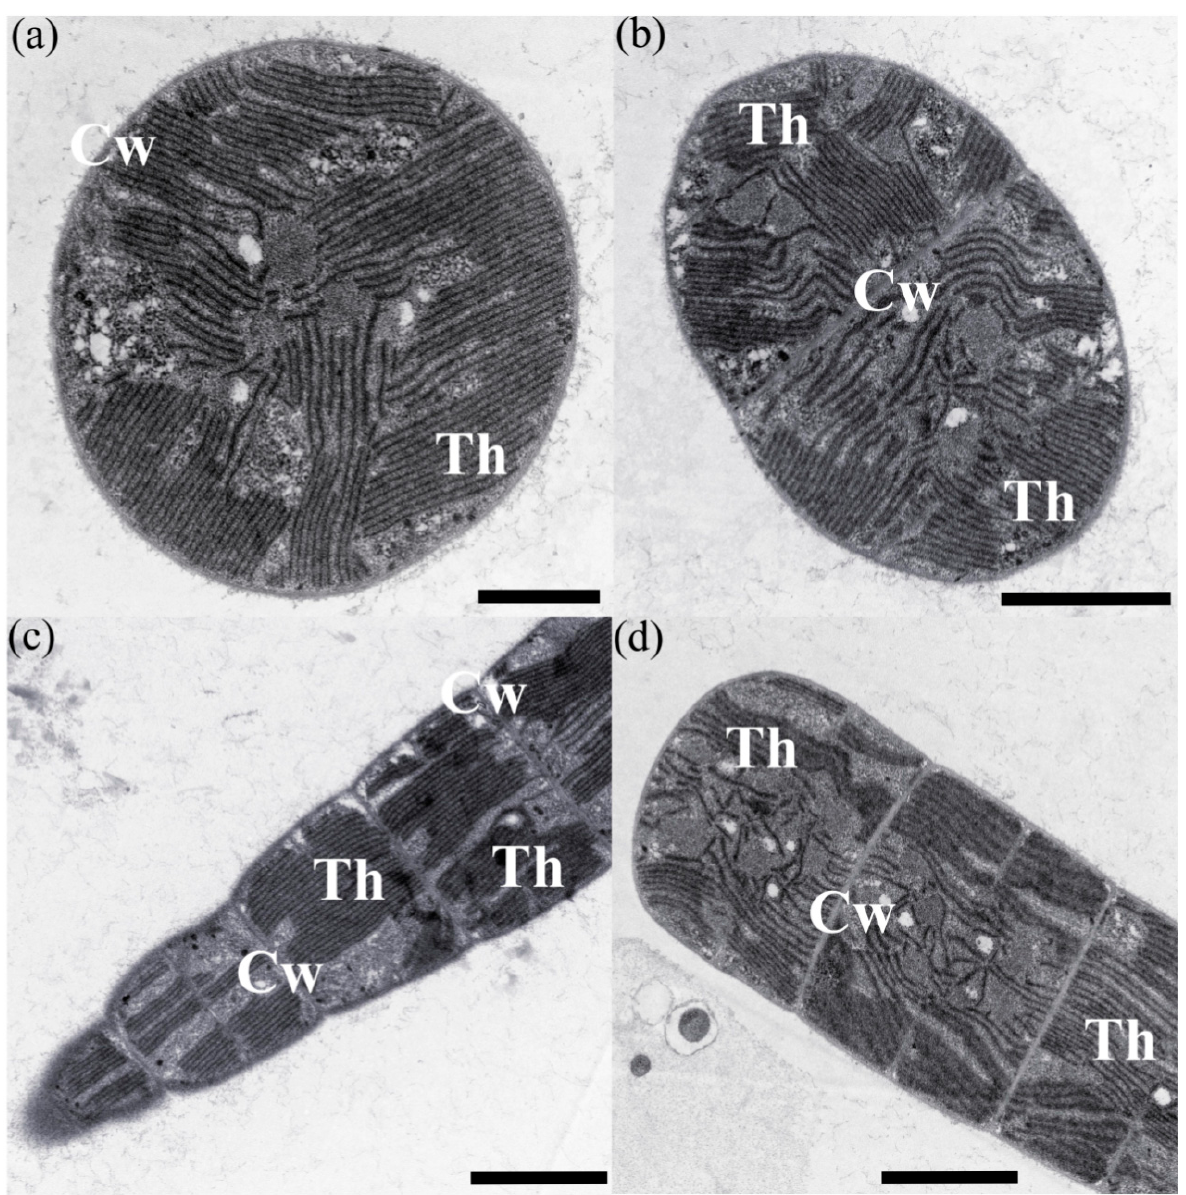
Figure 2. Ultrastructure of Microcoleusiopsis ganfuensis strains. ( Cw , cell wall, Th , thylakoids). ( a ) Transverse section. ( b – d ) Longitudinal sections. Scale bars: ( a – d ), 2 μ m.